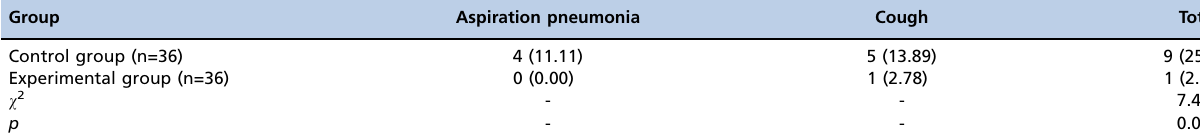
Table 3 - Comparison of incidence rate of complications between the two groups [n (%)]. Group